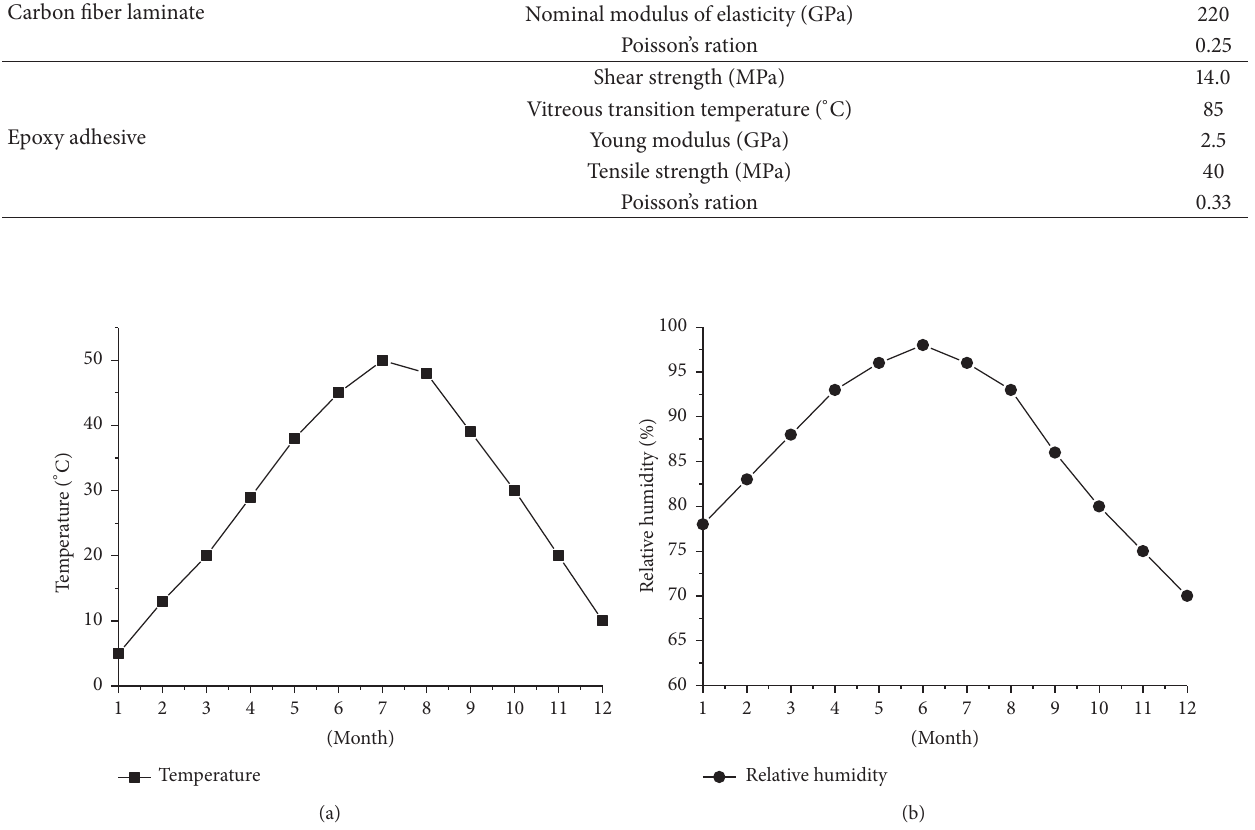
Figure 3: Monthly temperature and humidity curves over one year on the bridges in South